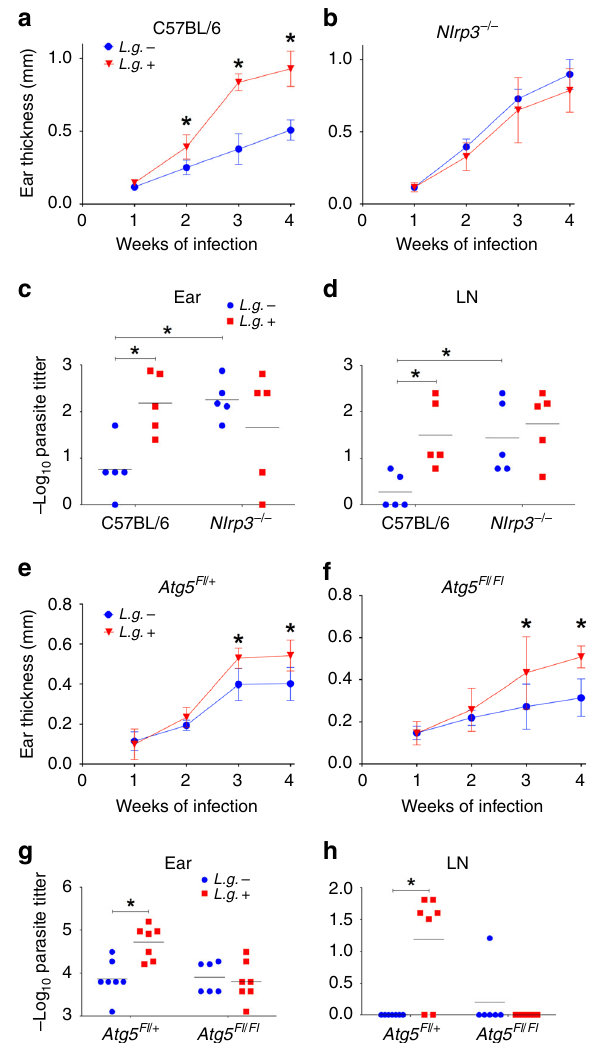
Fig. 8 LRV exacerbates L.g . infection via NLRP3 and ATG5 in vivo. a C57BL/ 6 and b Nlrp3 − / − mice were injected with 10 5 Metacyclic promastigotes of L.g .- or L.g . + ( n = 5 mice per group), and ear thicknesses were followed weekly. Four weeks after infection, parasite titers were determined in the ear ( c ) and draining lymph node ( d ). One representative of three independent experiments performed is shown. LysM Cre / Fl Atg5 + ( e ) and LysM Cre / Fl Atg5 Fl ( f ) mice were injected with 10 5 Metacyclic promastigotes of L.g . − or L.g . + and ear thicknesses were followed weekly. Four weeks after infection, parasite titers were determined in the ear ( g ) and draining lymph node ( h ). The results are shown as mean ( c , d , g , h ) or mean ± SD ( a , b , e , f ) from data pooled from two independent experiments ( n = 6 – 7 mice per group). Statistical analysis was performed by two-way ANOVA with Bonferroni ’ s multiple comparison test. P < 0.05 (*) was